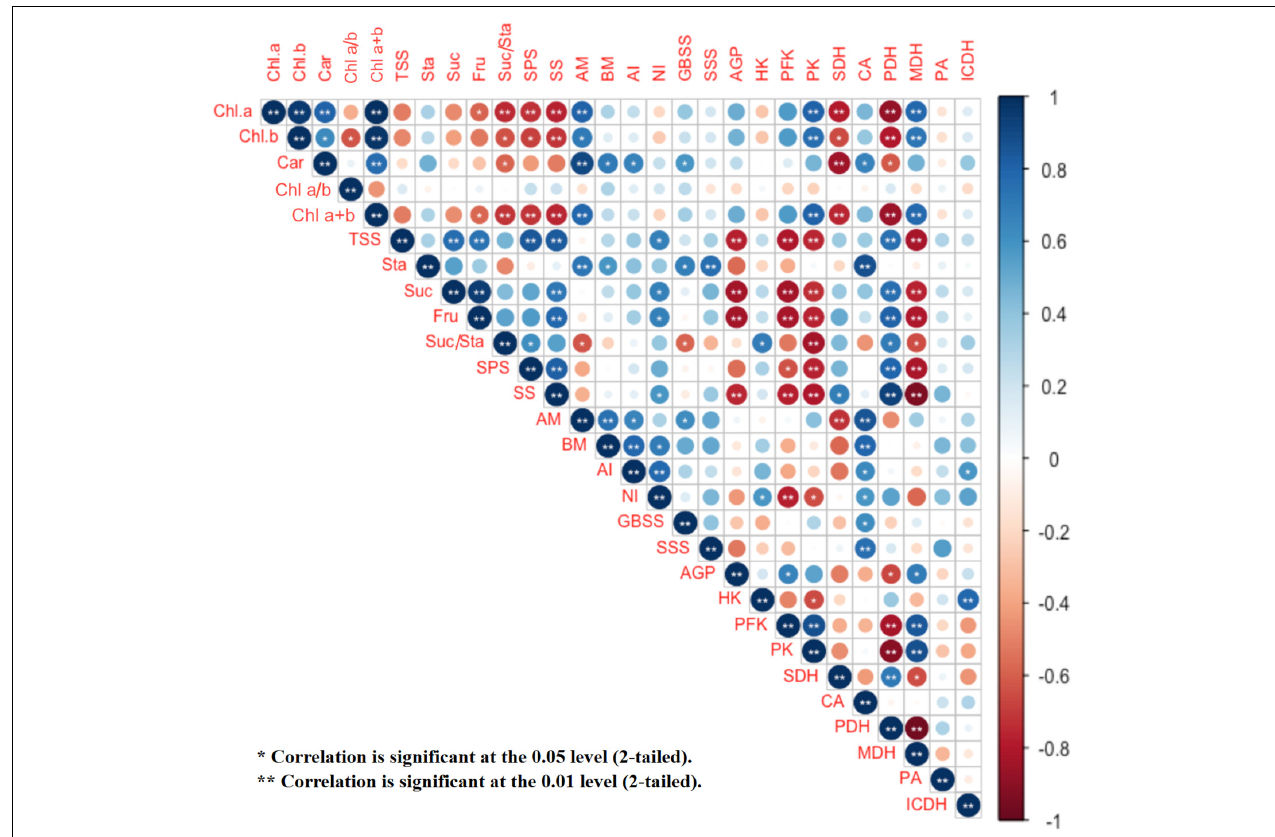
FIGURE 9 | Correlation analysis among G. uralensis photosynthetic pigment contents, starch and sucrose metabolism, EMP and TCA cycle indexes in the four treatments (CK, CK + G2, S, and S + G2). CK, control group; S, salt stress group; CKEE + G2, control combined with the G2 group; S + G2, salt stress combined with the G2 group. Chl a , chlorophyll a ; Chl b , chlorophyll b ; Car, carotenoids; AGP, ADP-glucose pyrophosphorylase; GBSS, granule-bound starch synthase; SSS, soluble starch synthase; AM, α -amylase; BM, β -amylase; SPS, sucrose-phosphate synthase; SS, sucrose synthase; AI, acid invertase; NI, neutral invertase; HK, hexokinase; PFK, phosphofructokinase; PK, pyruvate kinase; PDH, pyruvate dehydrogenase; ICDH, isocitrate dehydrogenase; SDH, succinate dehydrogenase; MDH, malate dehydrogenase; PA, pyruvate; CA, citrate; TSS, total soluble sugar; Sta, starch; Fru, fructose; Suc, sucrose.